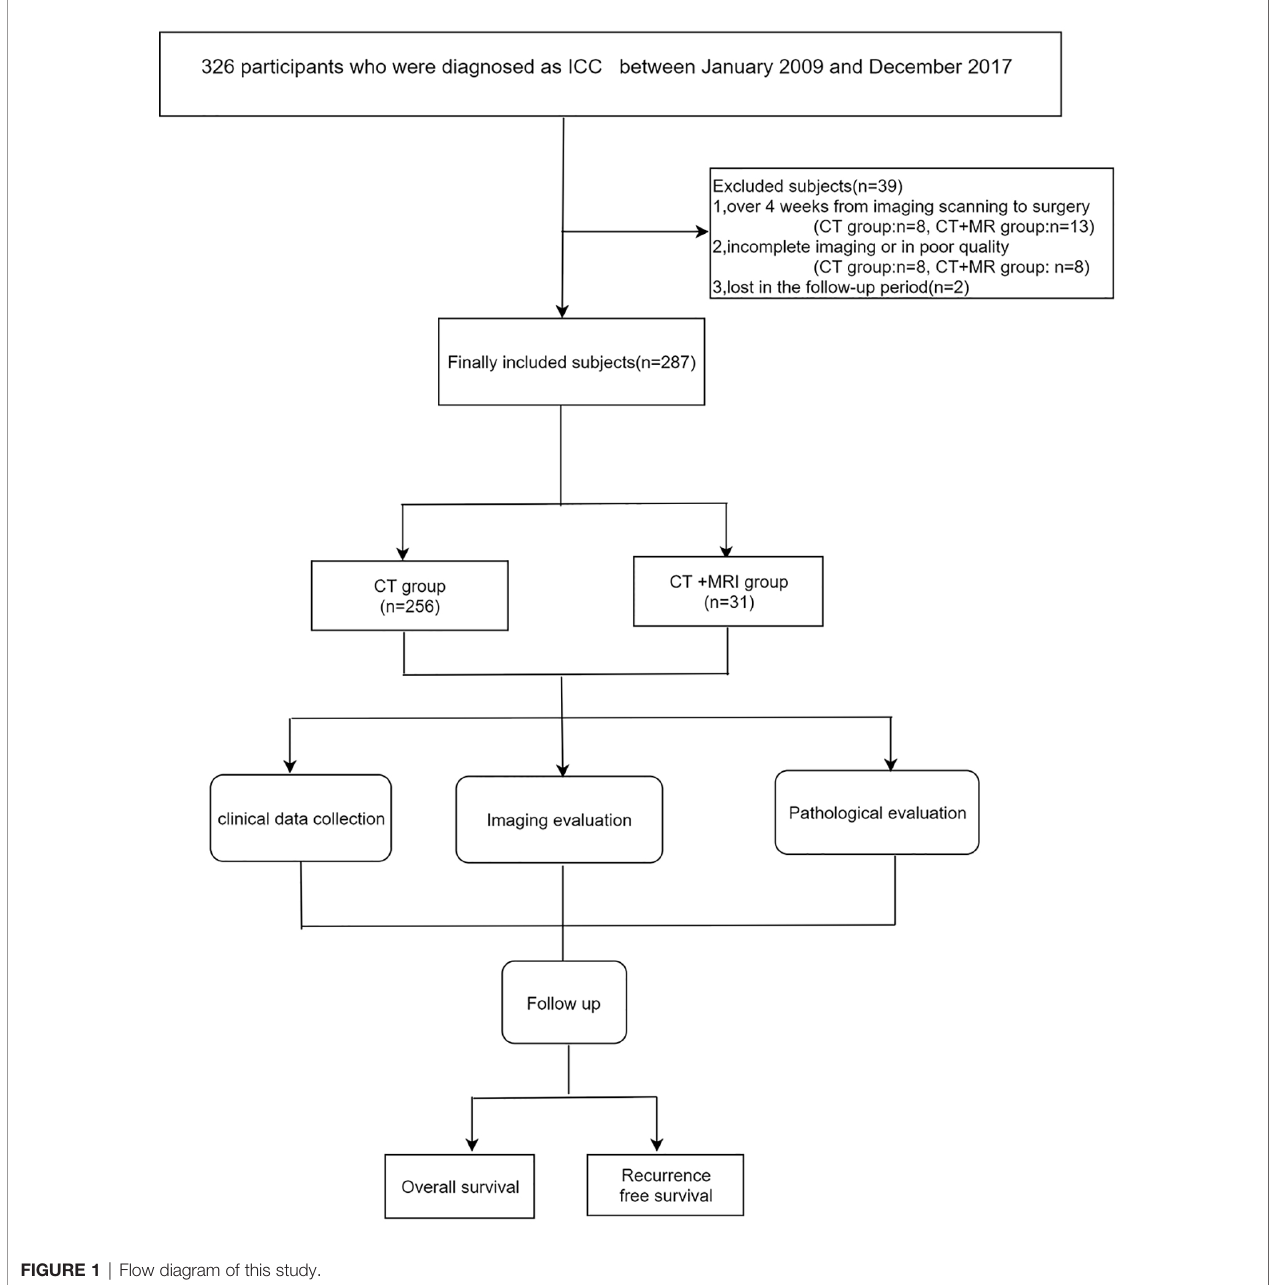
FIGURE 1 | Flow diagram of this